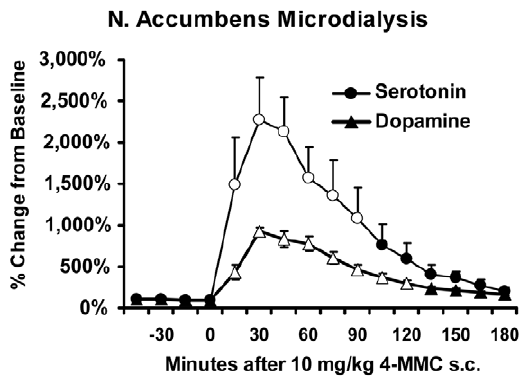
Figure 6. Serotonin and Dopamine levels in the nucleus accumbens (shell) region following 10 mg/kg 4-MMC, s.c. (N=5, ± SEM). Open symbols indicate significant change from